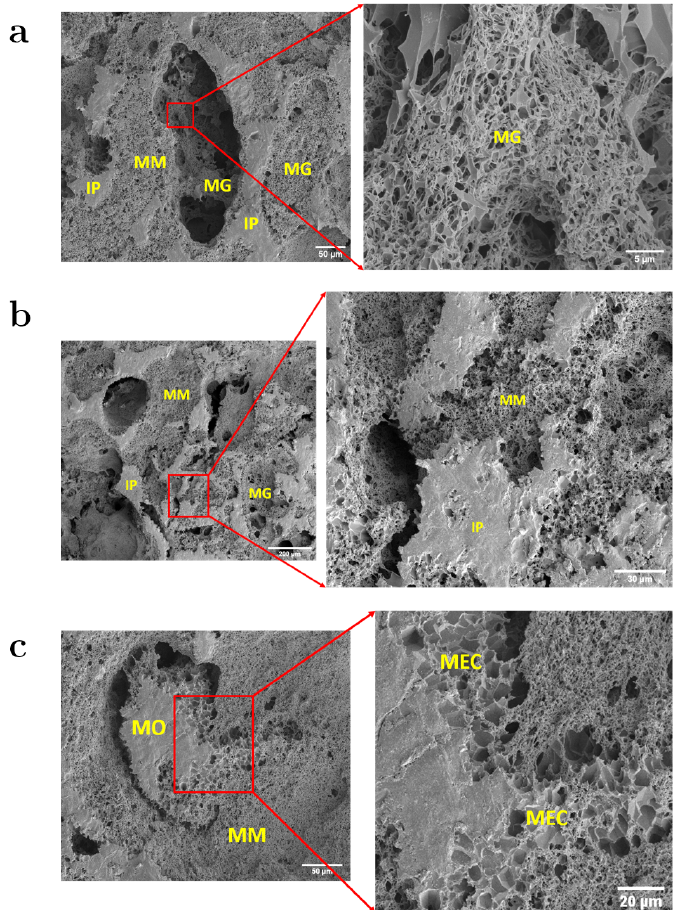
Figure 2. SEM images of the etched Arab-D pore casts showing the three carbonate microporosity types identified by Cantrell and Hagerty [23]; the solid represents the pore space and the etched away grains are black voids. ( a ) Interparticle (IP) macropores appear as solid epoxy, while type I microporosity in microporous grains (MG) appears as a fine network of sponge-like micropores. ( b ) The heavily micritized matrix type II microporosity is abundant throughout the sample. MM and MG seem to have very similar pore morphologies. ( c ) Intraparticle moldic pore (MO) appears as solid epoxy within a micritized grain. Type III microporosity in intercrystalline micropores (MEC) seems to interconnect the MO to the rest of the matrix pore network. Images by Ahmed Hassan